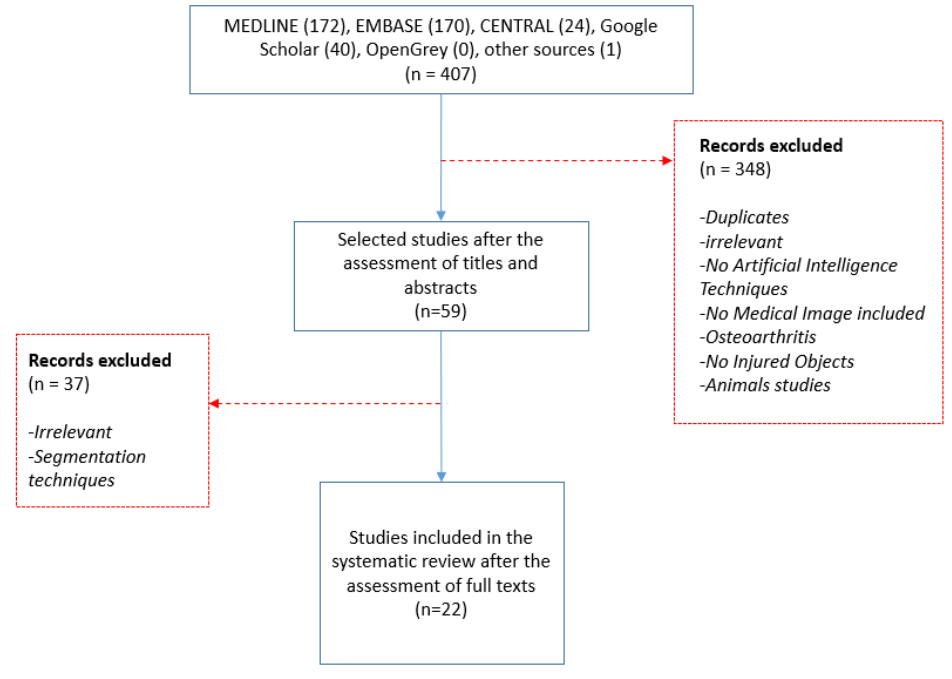
Figure 3. Flow chart presenting the design of the literature search.